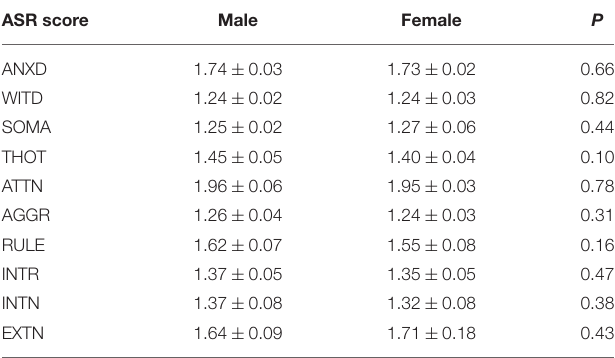
TABLE 3 | Estimation errors for predicting each ASR score for each